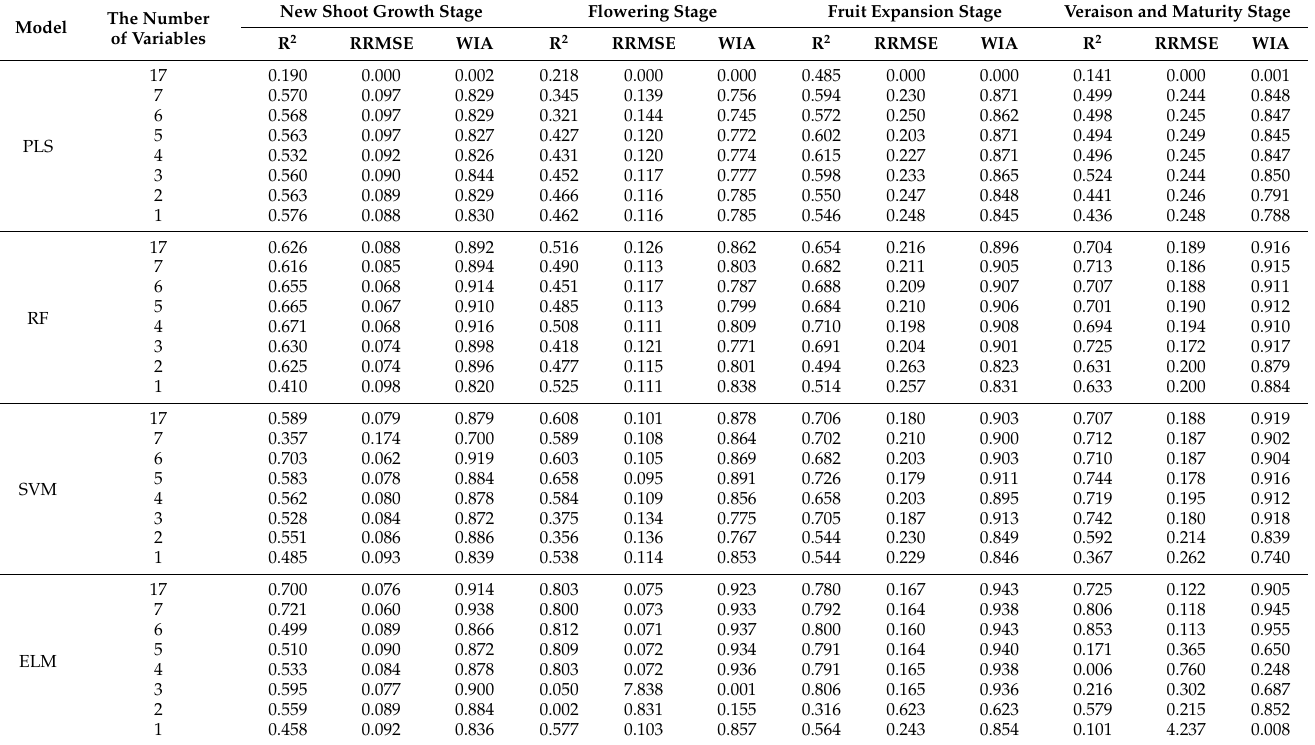
Table 4. Results analysis of LNC prediction model constructed based on different spectral variables.